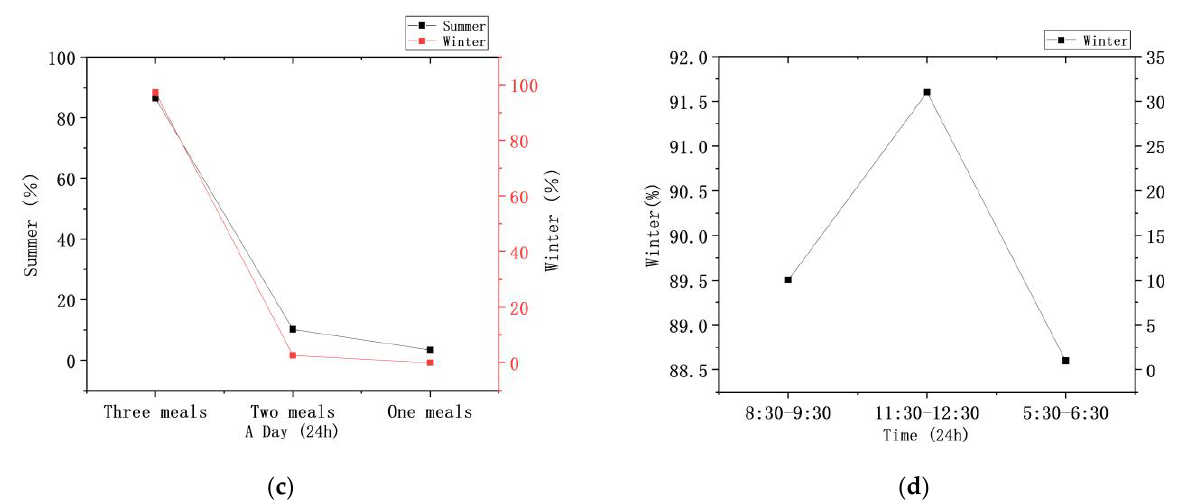
Figure 5. ( a ) Frequency of using cooking equipment; ( b ) Time taken for a single cooking session; ( c ) Number of meals a day; ( d ) Time taken for cooking three meals a day.